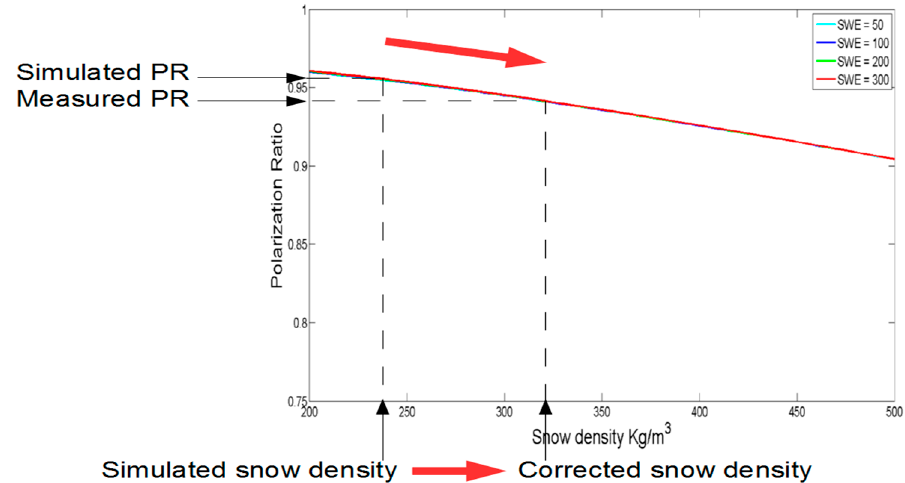
Figure 5. Theoretical relationship between snow density and the polarization ratio at 11GHz (PR11). The red line is derived from the HUT radiative transfer model, allowing the correction of simulated snow density by CLASS.